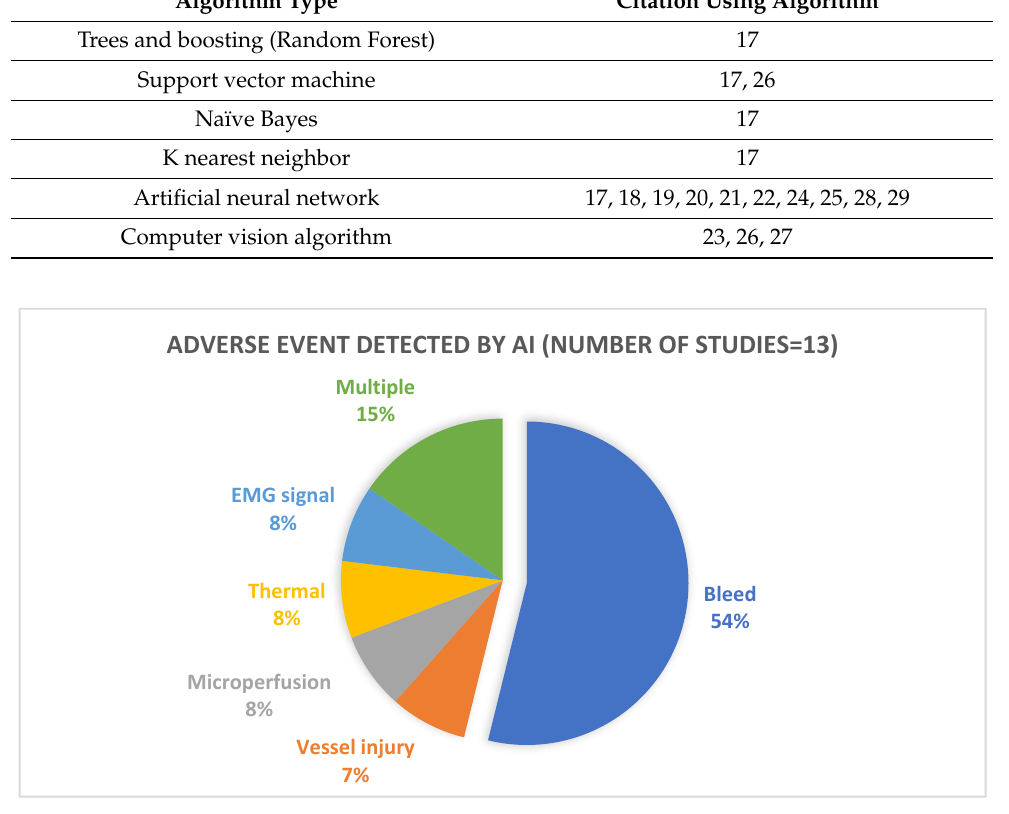
Table 2. Algorithm Used for Adverse Event Detection.